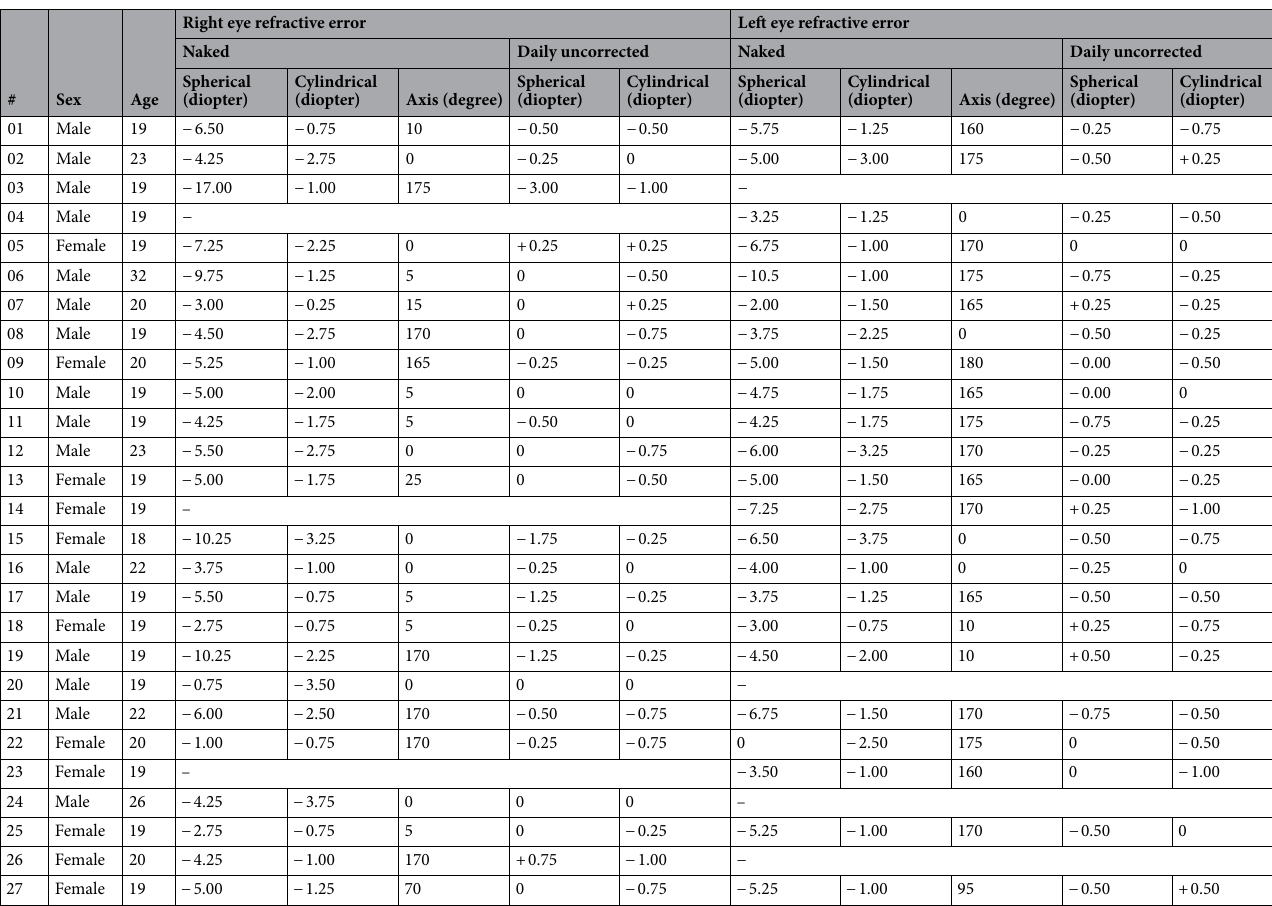
Table 1. The measured refractive errors of the chronic